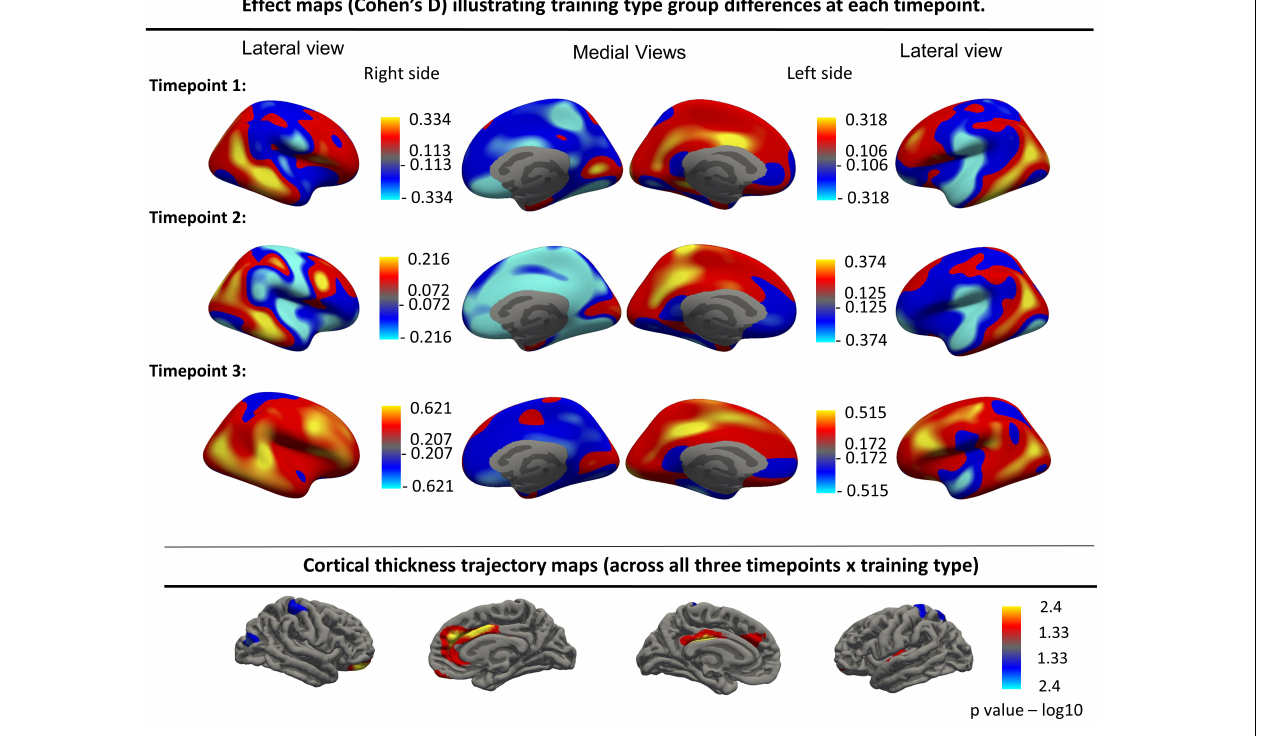
FIGURE 3 | Top panels: Effect maps (Cohen’s D) illustrating training type group differences at each timepoint for the left and right hemispheres. Bottom row: Cortical thickness trajectory maps showing the interaction effect (Time × Training type, uncorrected). These interaction effects were no longer significant after FDR correction. Resampled surface maps, were smoothed with kernel factor of 30 mm